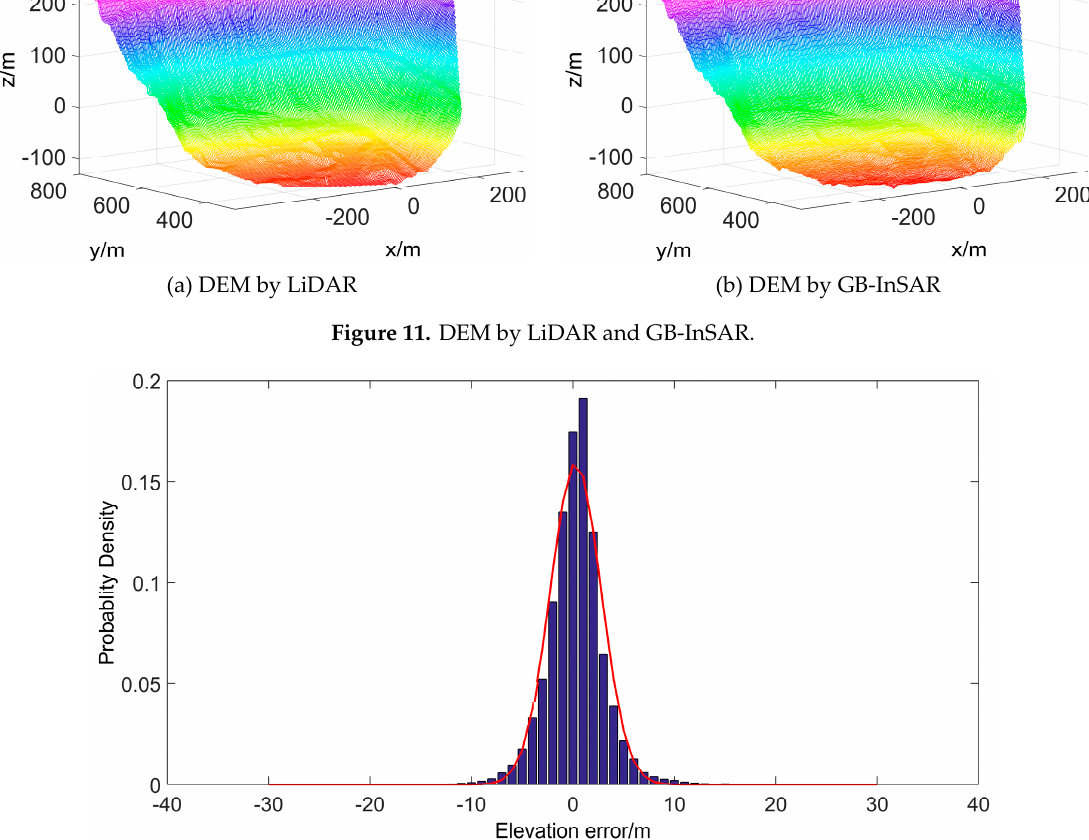
Figure 12. Statistical distribution of the DEM error and a Gaussian fitted curve.